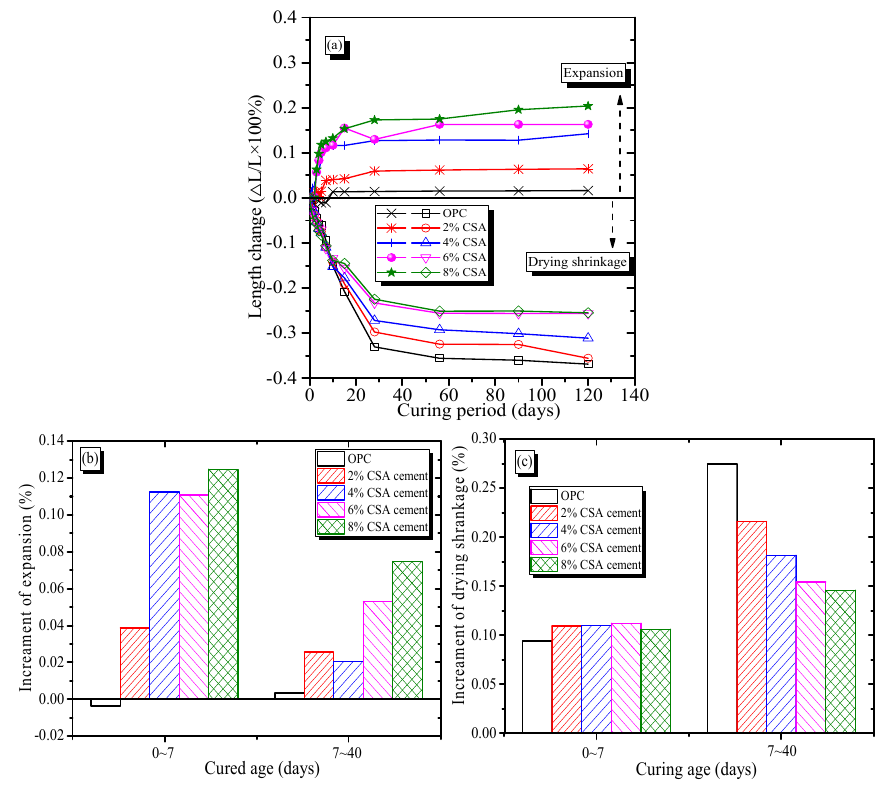
Figure 3. Effect of the CSA cement on the shrinkage–expansion characteristics of OPC mortars, ( a ) The volume change; ( b ) The percentage of expansion; ( c ) The percentage of shrinkage.